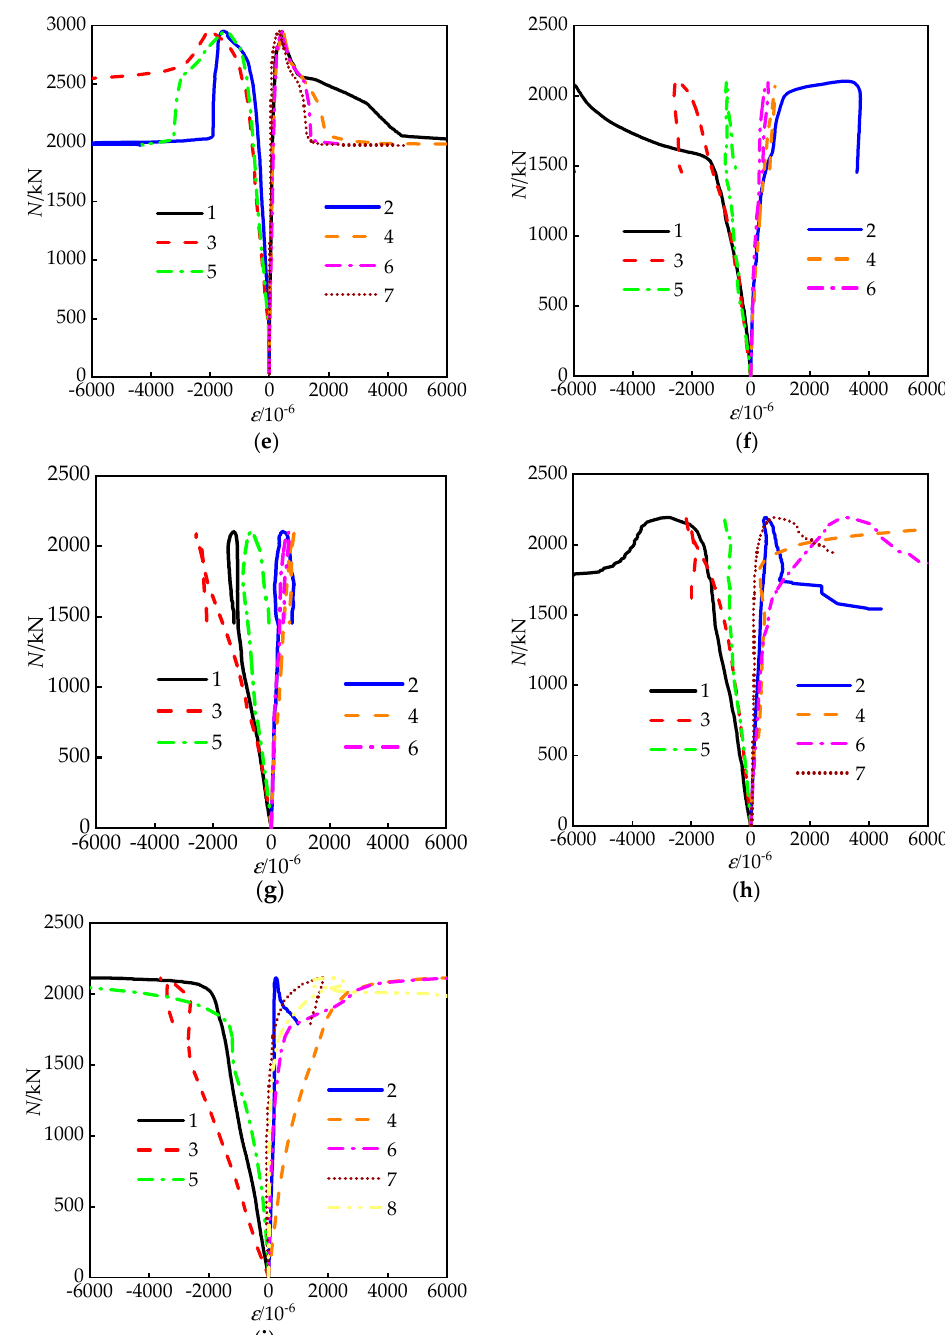
Figure 9. Strain curves of the steel tube at different measure point and direction: ( a ) RRCFST-1; ( b ) RRCFST-2; ( c ) RRCFST-3; ( d ) RRCFST-4; ( e ) RRCFST-5; ( f ) RRCFST-11; ( g ) RRCFST-12; ( h ) RRCFST-13; ( i ) RRCFST-14.